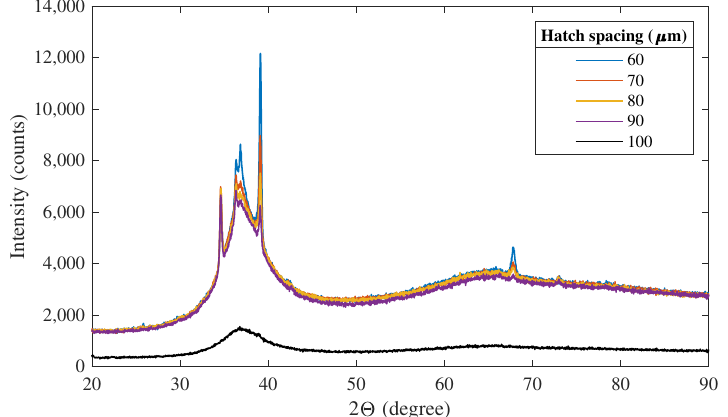
Figure 3. XRD scattering pattern of printed samples with varying hatch spacing [15]. The laser power and hatch length were kept constant at 80 W and 5 mm, respectively.